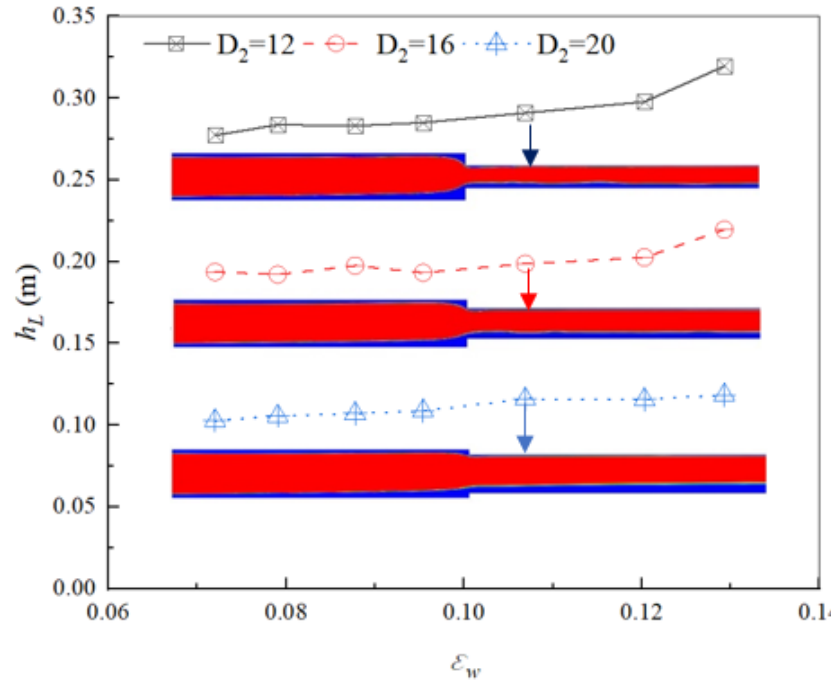
Figure 9. The effect of area ratio on the head loss.